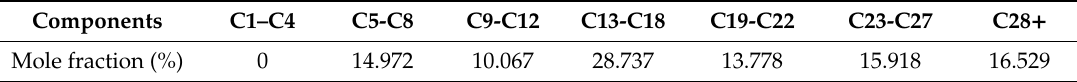
Table 1. Composition of dead crude oil components used in this